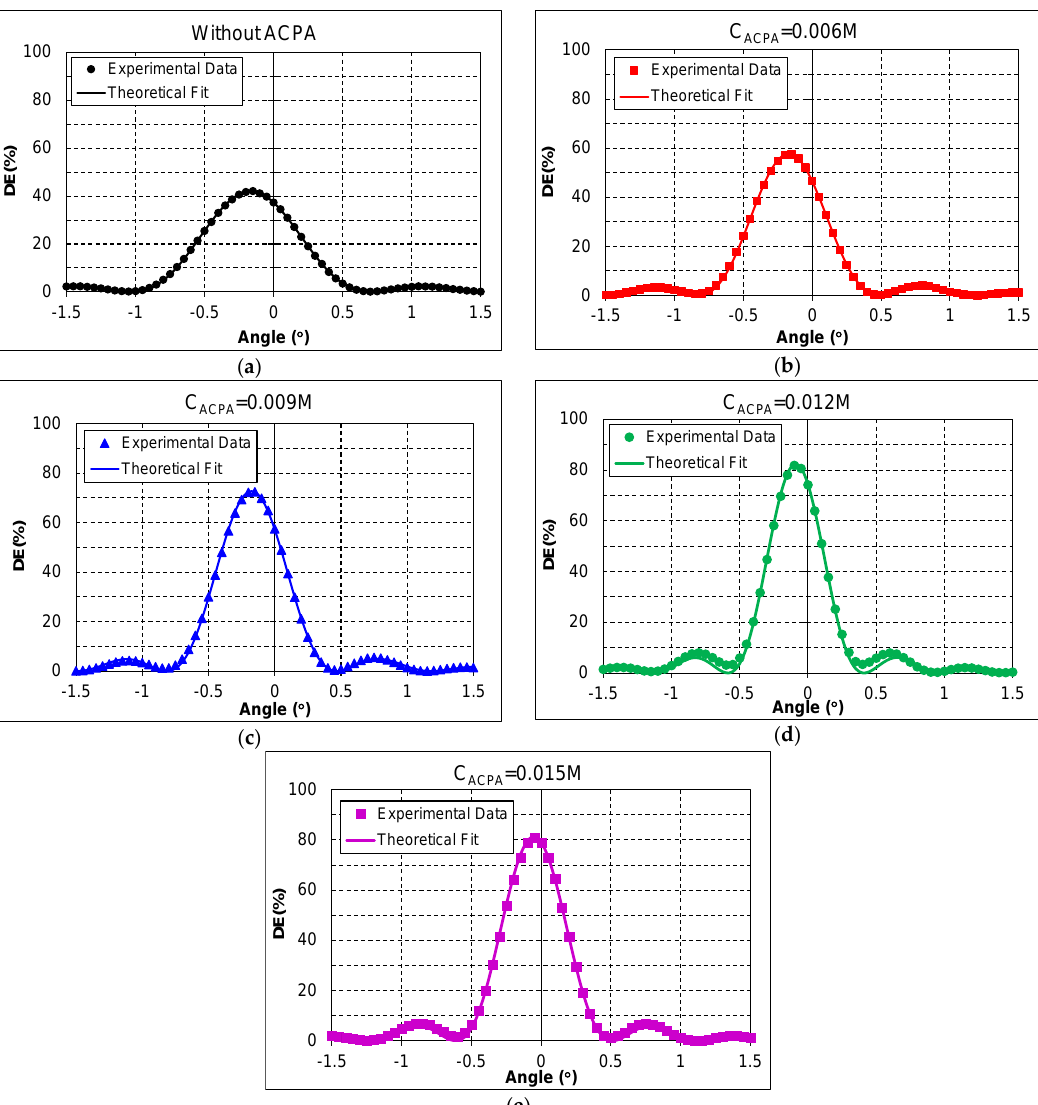
Figure 4. DE as a function of the reconstruction angle for transmission gratings stored with a spatial frequency of 2658 lines/mm for the compositions given in Table 1, ( a ) C1 without ACPA; (b) C2 with C ACPA = 0.006 M; ( c ) C3 with C ACPA = 0.009 M; ( d ) C4 with C ACP = 0.012 M; and ( e ) C5 with C ACPA = 0.015 M.